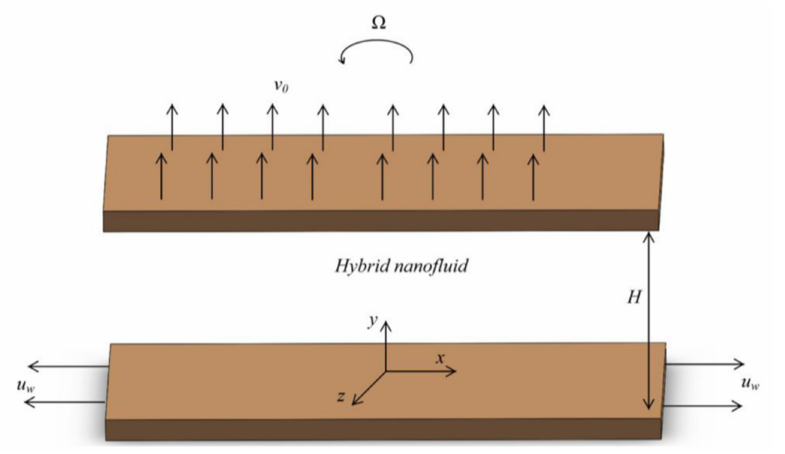
Figure 1. Geometry of the given flow